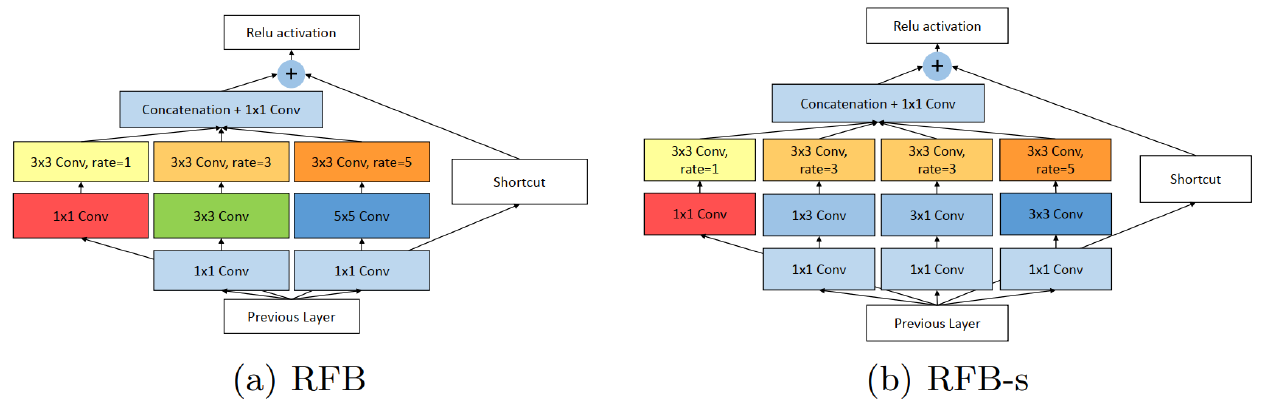
Figure 10. The explained architecture of RFB [56]. RFB is inspired by Receptive Fields (RFs) in human visual system. RFB considers the relationship between the size and eccentricity of receptive fields into account to enhance the features. ( a ) RFB is identical to Inception, responsible for simulating the RFs of multiple sizes, and ( b ) part reproduces the relation between the RF size and eccentricity in the human visual system by using smaller kernels. Reprinted from